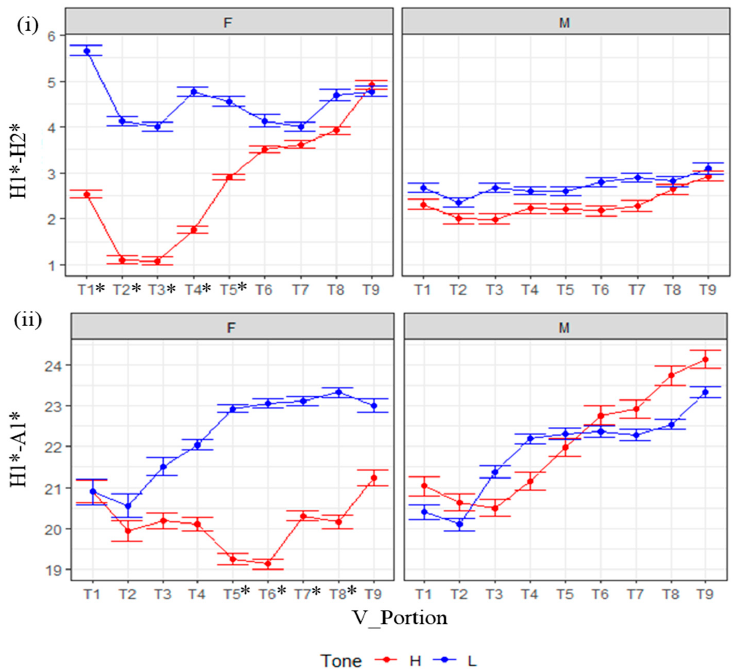
Figure 5. Scatter plots representing independent variables as a function of timepoints (T1 to T9) for ( i ) H1*–H2* and ( ii ) H1*–A1*. The asterisk (*) at each timepoint indicates significant interactions at a particular time point. F and M indicate female and male speakers’ data, respectively.